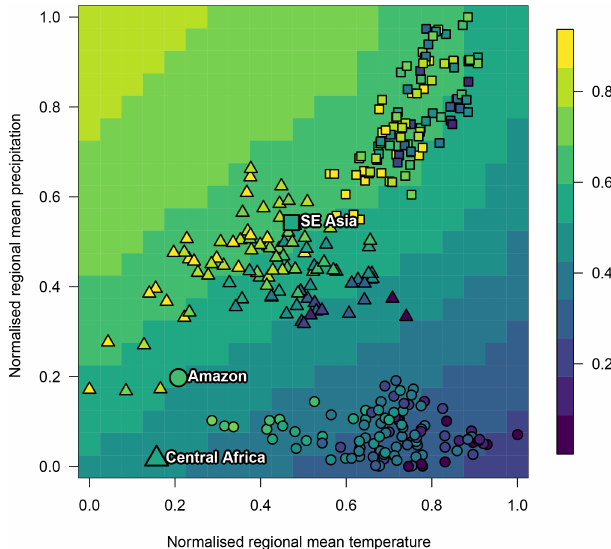
Figure 8. The impact of climate on forest fraction. Background plot colour indicates the mean emulated forest fraction when all land surface inputs are held at their default values. Temperature and pre- cipitation in the ensemble are marked with symbols, with the fill colour representing forest fraction. Larger symbols represent the values observed in the real